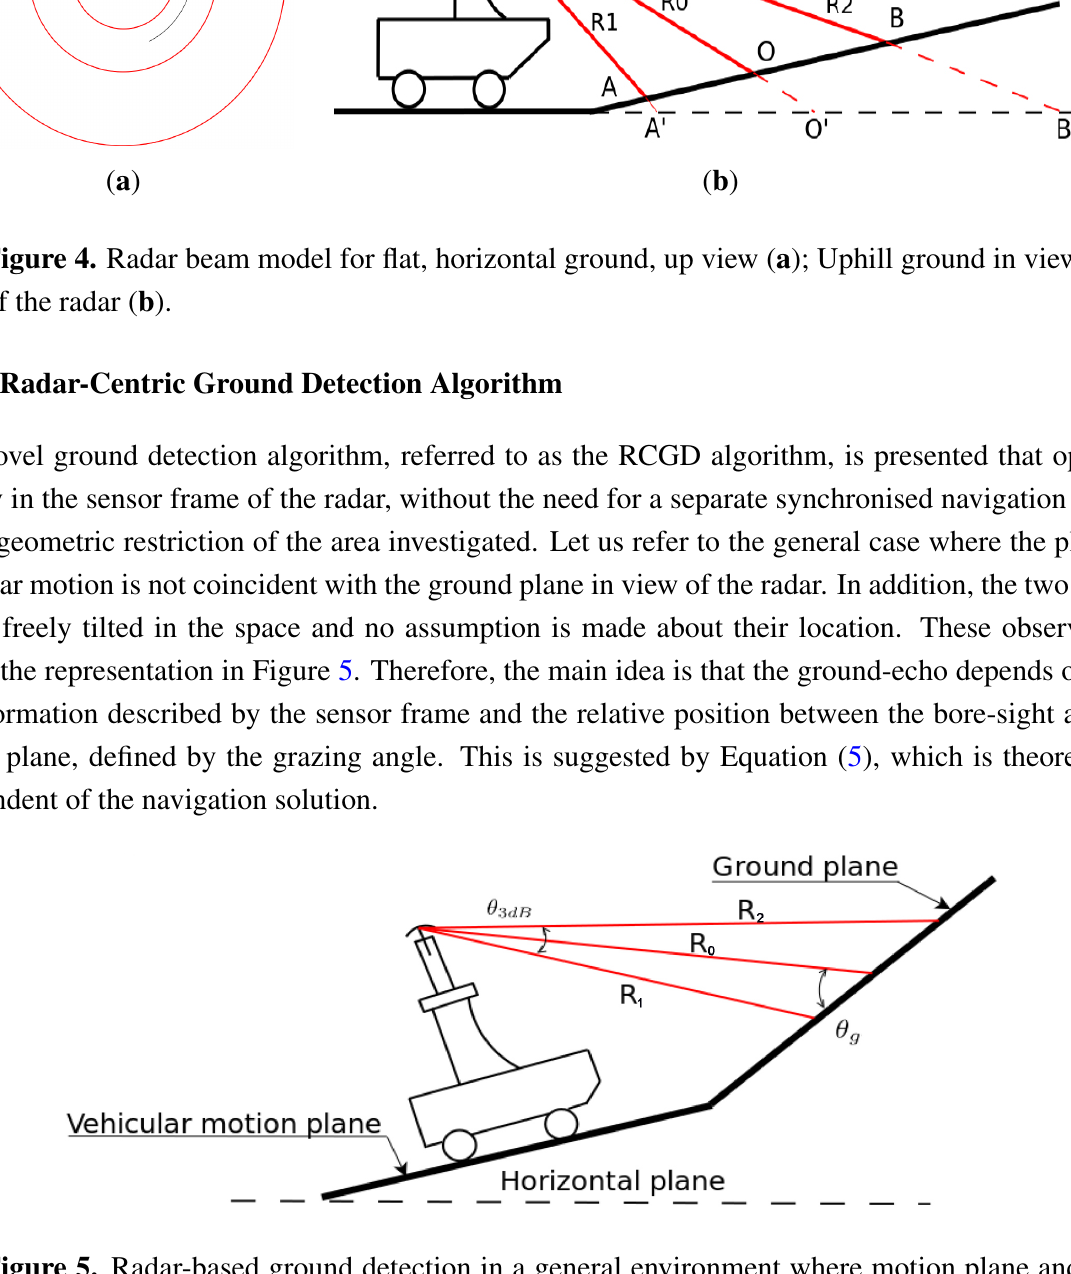
Figure 5. Radar-based ground detection in a general environment where motion plane and area under investigation do not